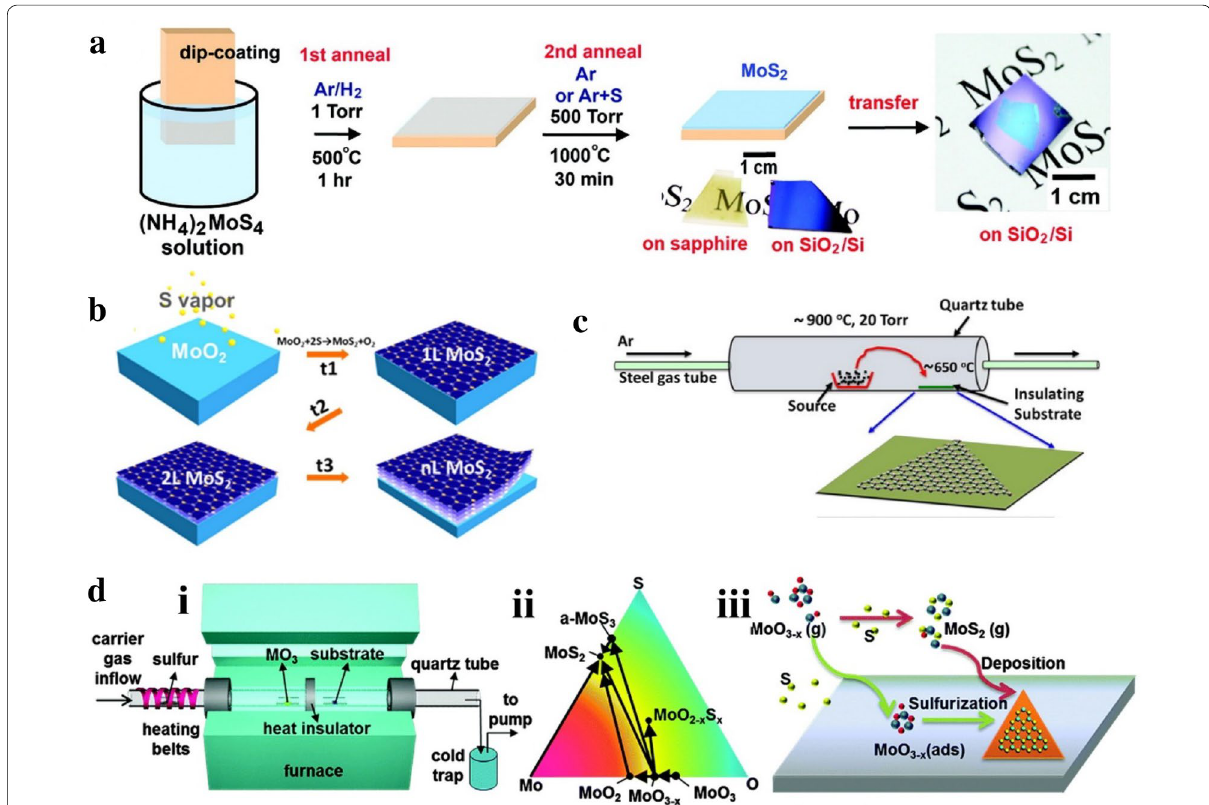
Fig. 1 4 types of growth routes for TMDs. a Two-step thermolysis process synthesis from (NH 4 ) 2 MoS 4 precursor on SiO 2 /Si or sapphire substrates followed by the two-step annealing process on insulating substrates and finally transferred onto another substrate [39], Copyright 2012, American Chemical Society. b Layer by layer deposition of MoS 2 from MoO 3 by surface sulfurization and transferred to another substrate one by one [45], Copyright 2013, American Chemical Society. c Simple vapor transport method showing MoS 2 films were deposited on insulating substrate at high temperature from MoS 2 powder precursor under inert atmosphere [47], Copyright 2013, American Chemical Society. d (i) LPCVD system setup for TMDs, (ii) Mo–O–S ternary phase diagram illustrating the pathways for the CVD growth of MoS 2 from MoO 3 precursors, and (iii) Possible growth routes of MoS 2 by the reaction of MoO 3 and S [36]. Copyright 2015, Royal Society of − x